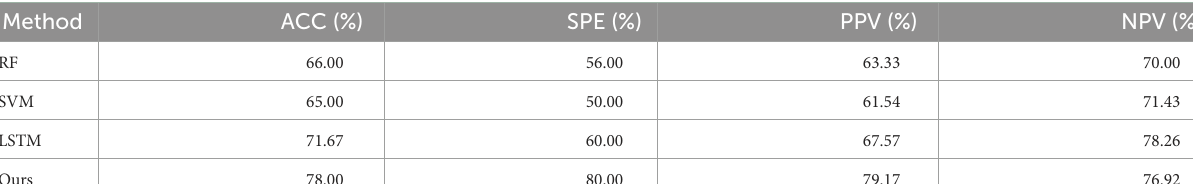
TABLE 2 Performances of the proposed method and the comparison